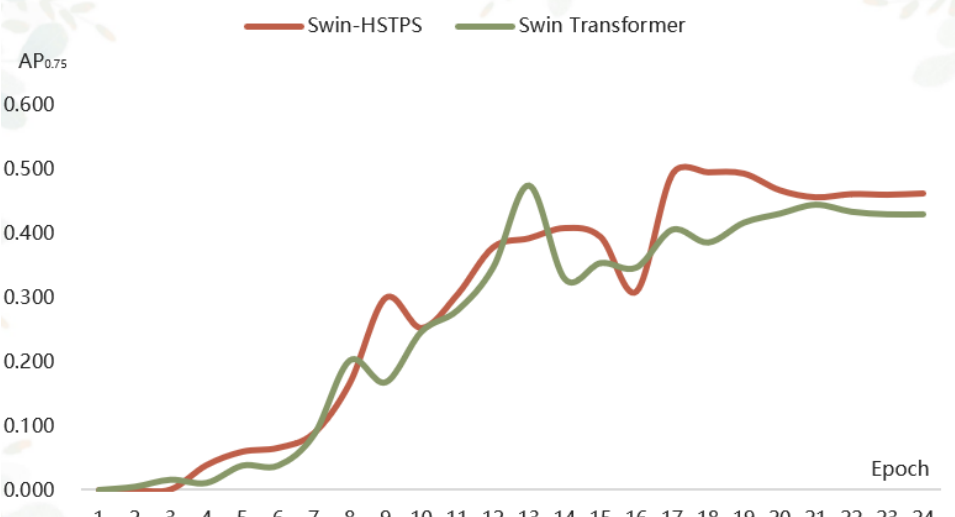
Figure 5. Average precision comparison chart (AP 0.75 ).